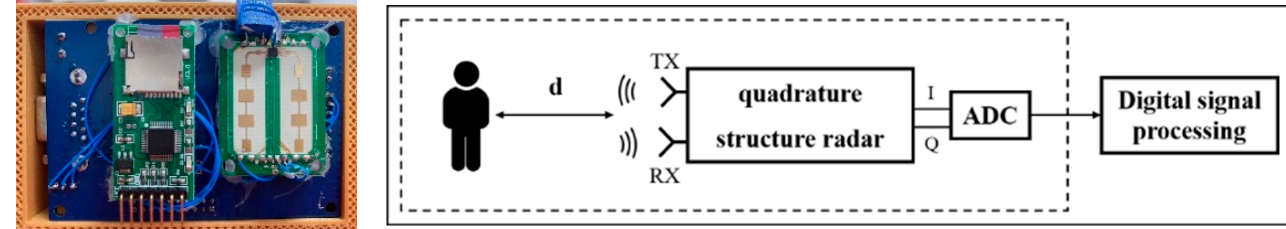
Figure 4. The device diagram and brief block diagram of doppler radar detection system.